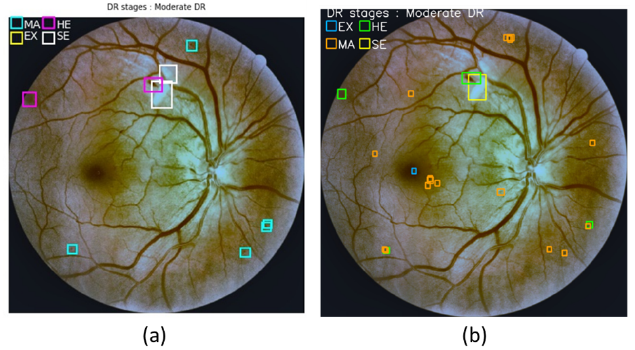
Figure 13. Sample of the DDR images visualization for: ( a ) the ground truth images annotation, ( b ) predicted images by fused